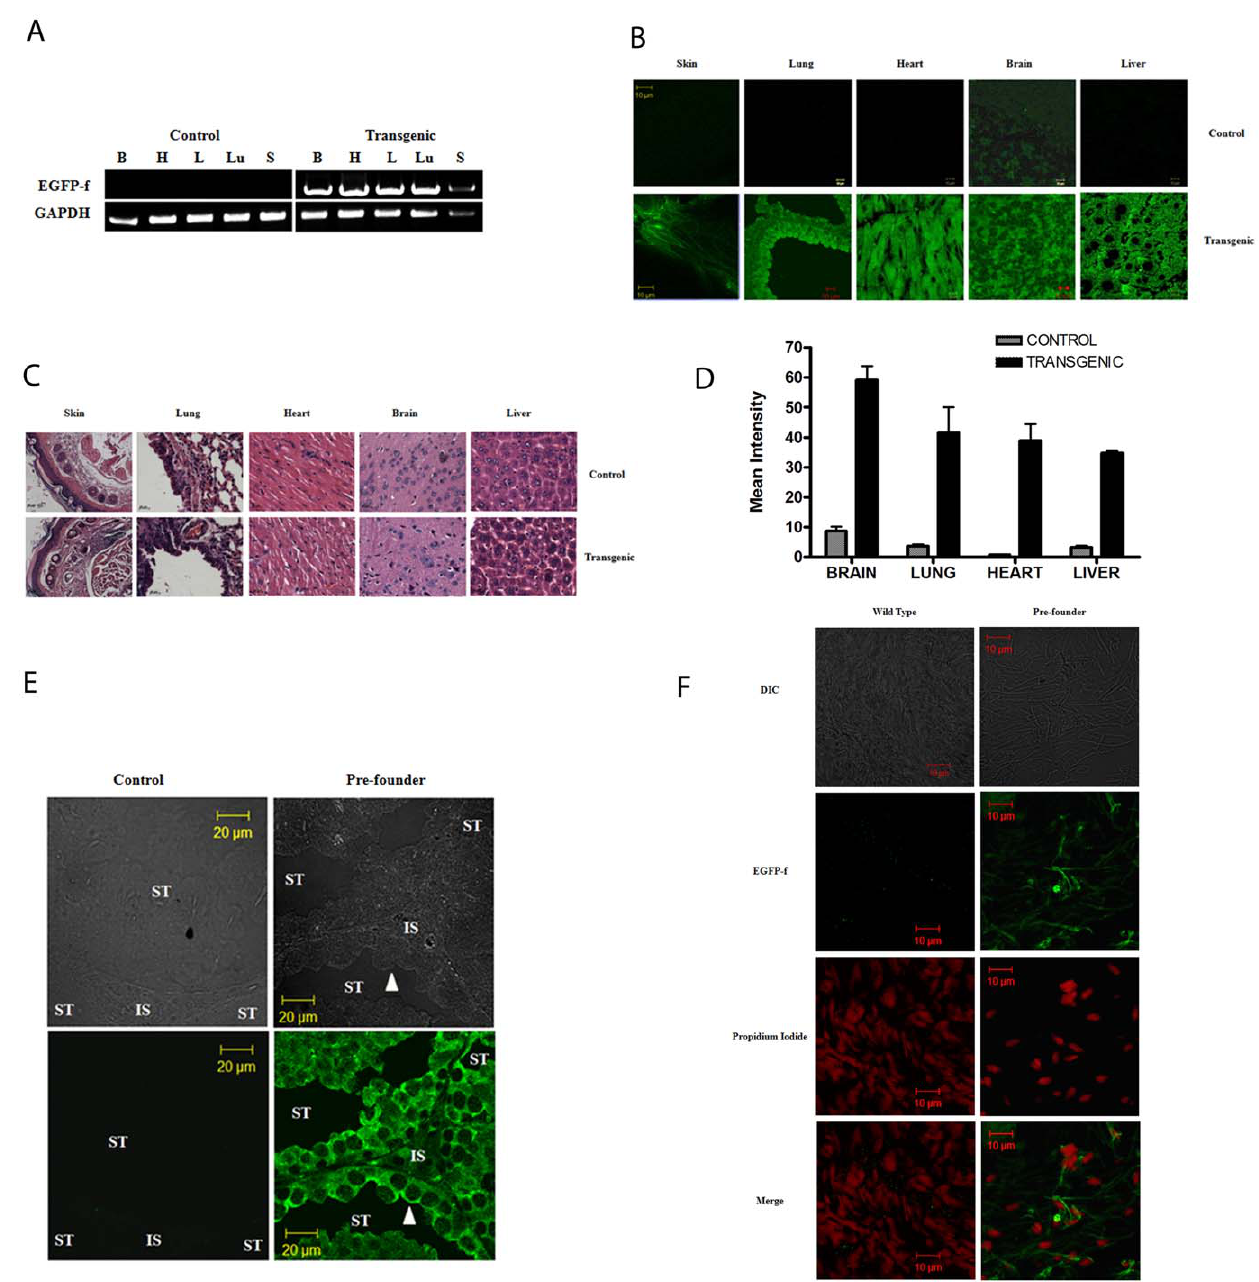
Figure 2. EGFP-f expression in various tissues of founder mice. A . Multiple tissue sections from control and transgenic littermates were analyzed for the expression of EGFP-f mRNA by RT-PCR analysis. Control mice did not show the presence of the EGFP-f mRNA but transgenic mice showed the expression of the EGFP-f mRNA in multiple tissues (H=heart, B=brain, L=liver, Lu=lung and S=skin). An RT-PCR was performed for GAPDH as a loading control. B . Multiple tissue sections from control and transgenic littermates were analyzed for the expression of the EGFP-f transgene by confocal microscopy. Original magnification is 630 6 . Scale bars are shown in the figures. C . Hematoxylin and eosin stained sections from wild type or transgenic mice. Original magnification is 630 6 . Scale bars are shown in the figures. D . The mean fluorescence intensity from control and transgenic sections is on the Y-axis and the different tissues are represented on the X-axis. The error bars represent the standard deviation for sections derived from at least three different mice. E . Testis sections from control mice or pre-founder mice were stained with antibodies to GFP followed by immunflourescence analysis and confocal microcospy. The top panel shows the DIC image of the fluorescence field. Note that the pre-founder mice show high levels of EGFP-f expression in both cells in the interstitial spaces and in spermatogonial stem cells (filled arrow) that line the basement membrane of the seminiferous tubules. Original magnification is 630 6 and scale bars are indicated in the figures. ST=seminiferous tubule and IS=interstitial spaces. F . Epididymis sections from control mice or pre-founder mice were stained with antibodies to GFP (green) and propidium iodide (red) to stain DNA, followed by immunflourescence analysis and confocal microcospy. The top panel shows the DIC image of the fluorescence field and the bottom panel shows the merged image. Note that the pre-founder mice show high levels of EGFP-f expression in the sperm tails in the profounder mouse but not in WT mice. Original magnification is 630 6 and scale bars are indicated in the figures.